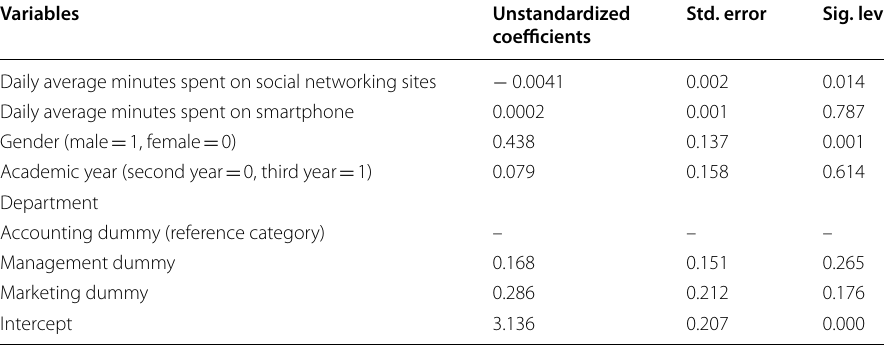
Table 3 Estimation result of the linear regression model